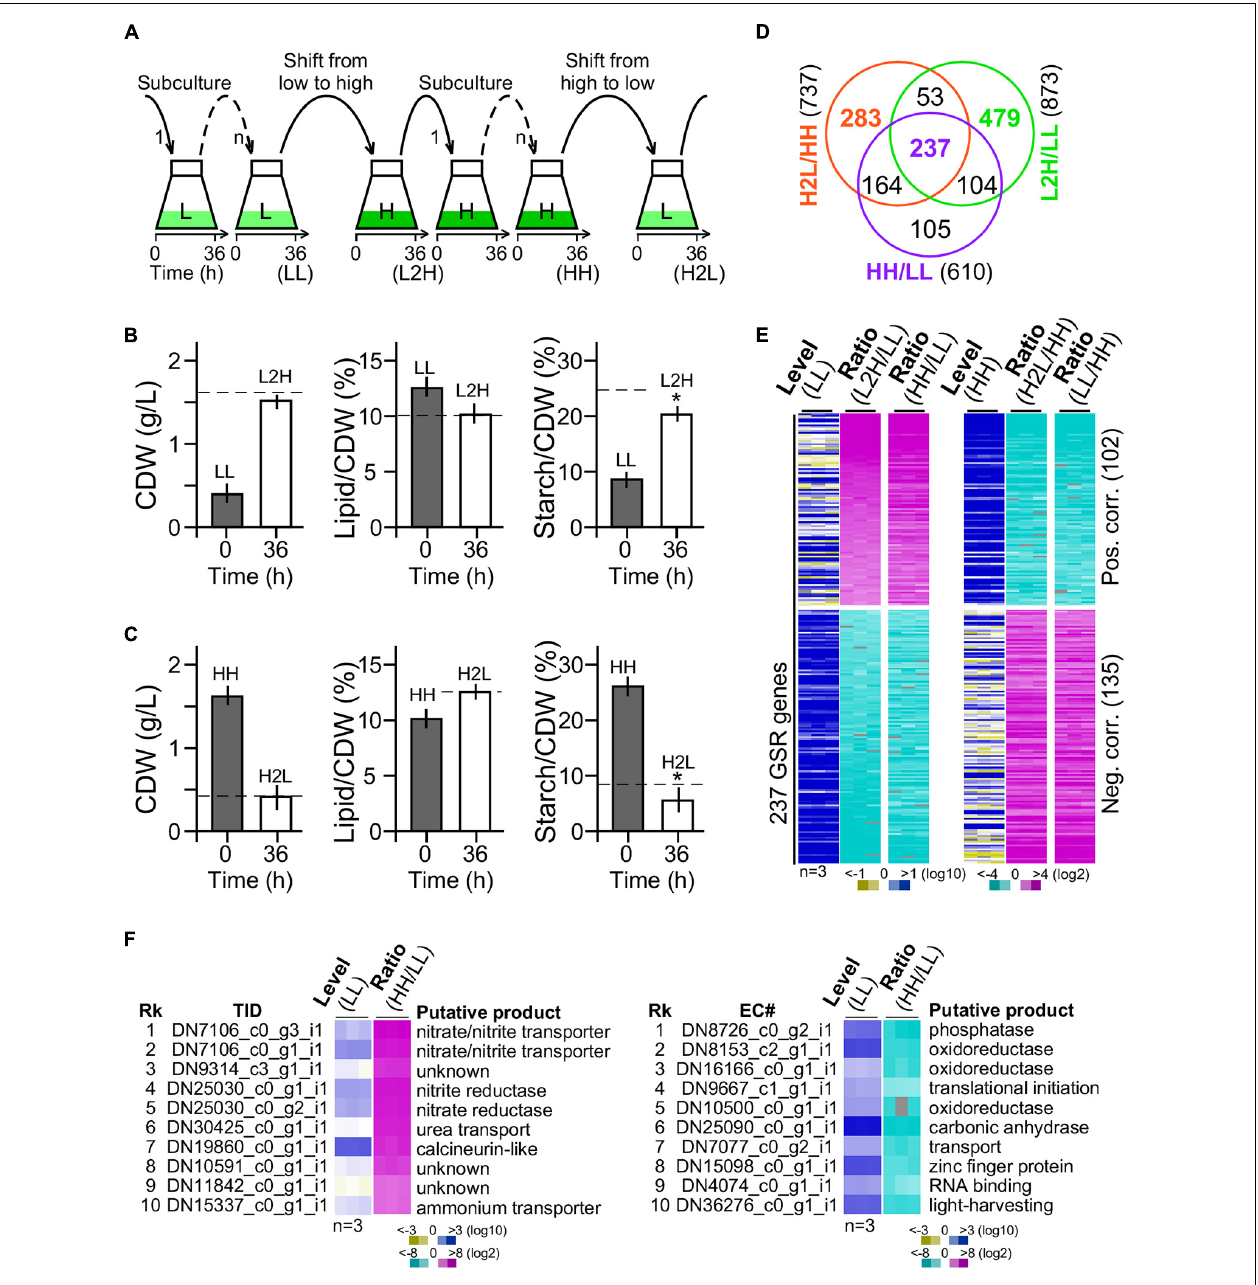
FIGURE 3 | Transcriptomic profiling of G32 cells maintained in and shifted to medium with different levels of glucose supplementation. (A) Schematic drawing of G32 culture maintenance and medium shift. Subculture in low-glucose and high-glucose media and shift to medium with different levels of glucose supplementation at 36 h after inoculation. (B) Bar plots showing the CDW, lipid, and starch contents upon medium shift from low glucose to high glucose supplementation (L2H). Dashed line indicates the level in cells adapted to high glucose supplementation (HH). Asterisk “*” indicates the statistical significance of difference between starch levels in L2H and HH samples. (C) Bar plots showing the CDW, starch, and lipid contents upon medium shift from high to low glucose supplement (H2L). Dashed line indicates the level in cells adapted to low glucose supplement levels (LL). (D) Venn diagram of DEGs between L2H/LL, H2L/HH, and HH/LL. (E) Heatmap of the 237 GSR genes profile. Level and ratio are shown. Color keys are shown at the bottom. (F) Top 10 most upregulated (left panel) and downregulated (right panel) genes. Rk and TID stand for rank and transcript ID, respectively.